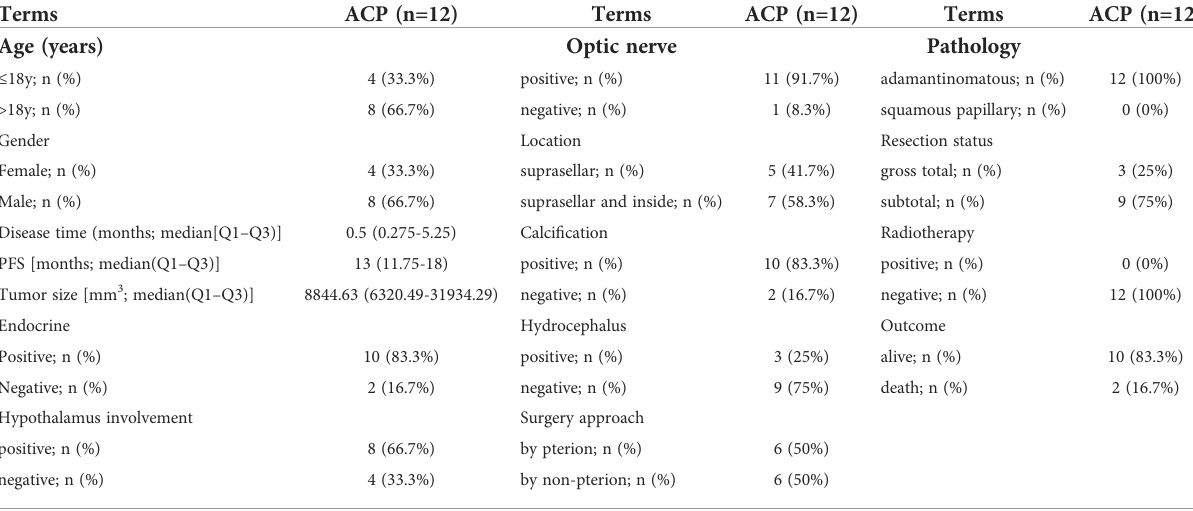
TABLE 2 Clinical characteristics of adamantinomatous craniopharyngioma patients in our sequencing